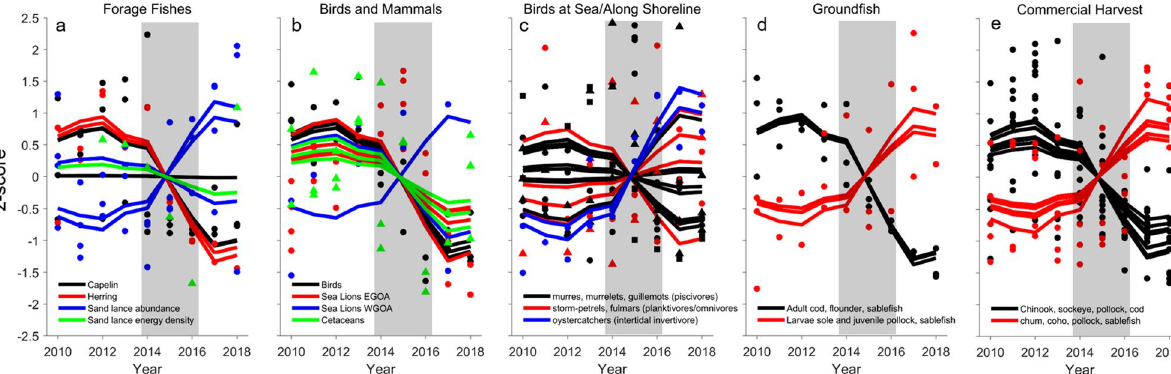
Figure 4. Response of mid and upper trophic level species during the Pacific marine heatwave. ( a ) Abundance of juvenile capelin and sand lance from marine bird diets and of herring spawn, herring age-3 growth, and sand lance body condition in Prince William Sound (PWS). ( b ) Abundance of nesting murres on East Amatuli Island, kittiwake nests in Prince William Sound (“birds”), Steller sea lion pups and non-pups on rookeries and haul-out sites in eastern and western Gulf of Alaska (GOA), humpback and killer whale encounter rates, and killer whale numbers (“cetaceans”). ( c ) Marine bird abundance of primarily piscivores including common murres (black dots) from PWS and the Seward Line, murrelets (black triangles) from PWS, Kenai and Alaska Peninsulas, and pigeon guillemots (black squares) from Kenai and Alaska Peninsulas; primarily planktivores/omnivores including storm-petrels (red dots) and northern fulmars (red triangles) along the Seward Line; and intertidal invertebrate consumers—black oystercatchers—from Kenai and Alaska Peninsulas. ( d ) Adult female spawning biomass of Pacific cod, arrowtooth flounder, and sablefish, and larval southern rock sole, juvenile pollock, and growth of juvenile sablefish. (e) Commercial harvest in pounds landed and ex-vessel revenue for salmon and groundfish species from regions throughout our eastern and western study areas. Points are annual values and lines are models fit to data. Grey shading represents the 2014–2016 northeast Pacific marine heatwave. Values are z-score standardizations so the y-axes are